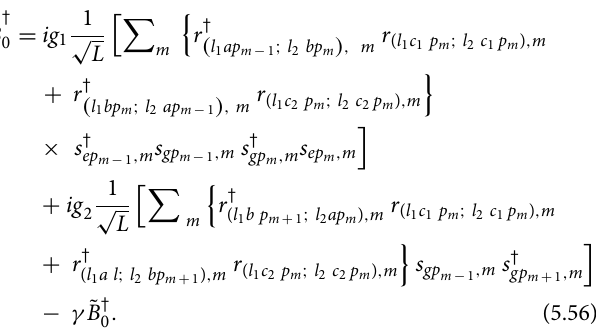
equivalents of the selected operators are: Bp 2 and B † p , damping constant is set to γ B 2 3 g 1 g 2 0 . 1 = =